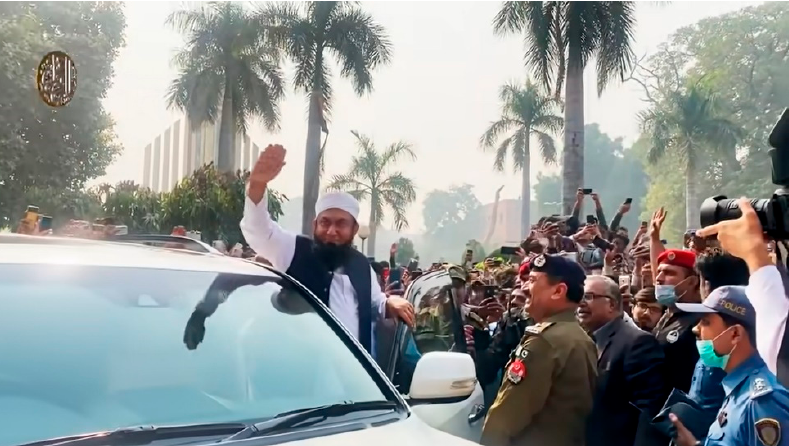
Figure 15. Maulana Tariq Jamil greeted by hordes of adoring students during a visit to the University of Agriculture, Faisalabad in November 2021. Source: https://www.youtube.com/watch?v=ir5-o6cI72k.